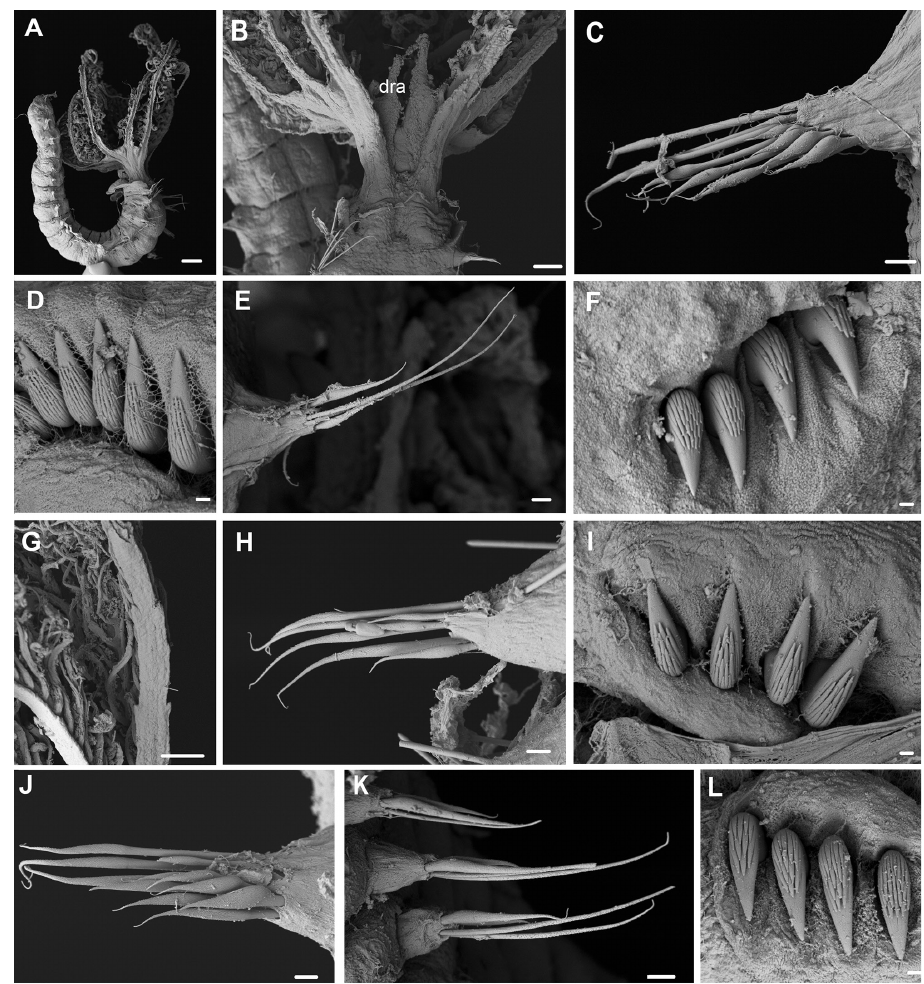
Figure 9. Pseudobranchiomma cf. P. schizogenica . Scanning electron micrographs. A–F specimen from Queensland AM W.37205 G–L specimen from Western Australia AM W.37203. A Whole specimen, lateral view B Base of crown, dorsal view with dorsal lips and radiolar appendages C Notopodia, second thoracic segment D Uncini, third thoracic segment E Posterior abdominal neurochaetae F Uncini, posterior abdominal segment G Detail of lateral radiole with serrations in flanges H Notopodia, first thoracic segment I Uncini, fifth thoracic segment J Notopodia fourth thoracic segment K Neuropodia, mid abdominal chaeti- gers L Posterior abdominal uncini. Scale bars: A = 200 µm; B, G = 100 µm; C = 20 µm; D, F, I, L = 2 µm; E, H, J, K = 10